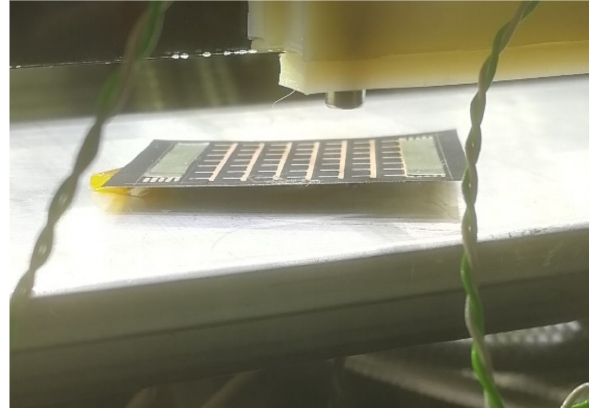
Figure 16. Non-coated sample in the test plane; Kapton spacers between thermal plate and sample to avoid thermal coupling; thermocouple type